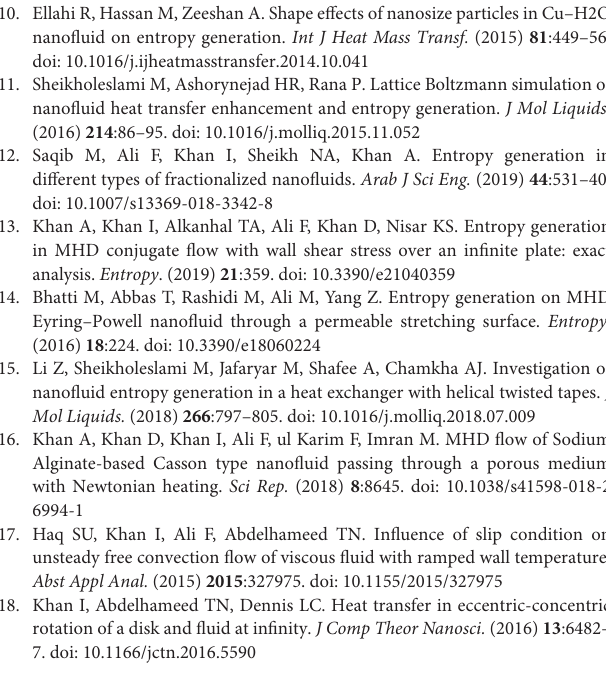
Table 1 examines the effect of different factors on skin friction. It is observed that the skin friction increases with increasing τ , β , and Gr values. Table 2 highlights the effect of the variation in τ and Pr on Nusselt number. The Nusselt number decreases up to the maximum value of τ and increases for the maximum value of